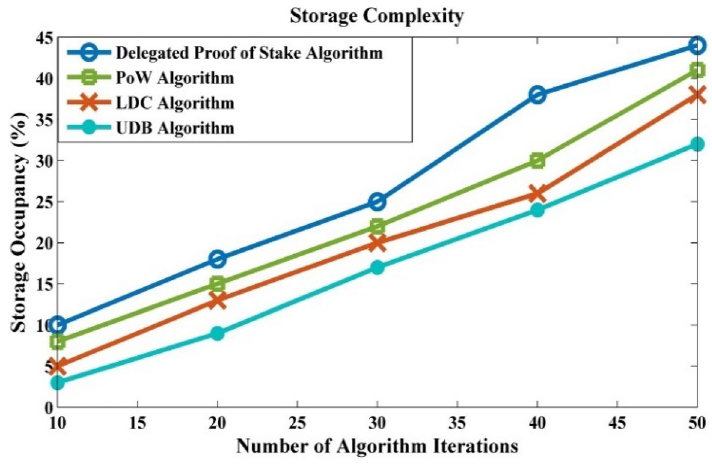
Figure 11. Storage complexity.